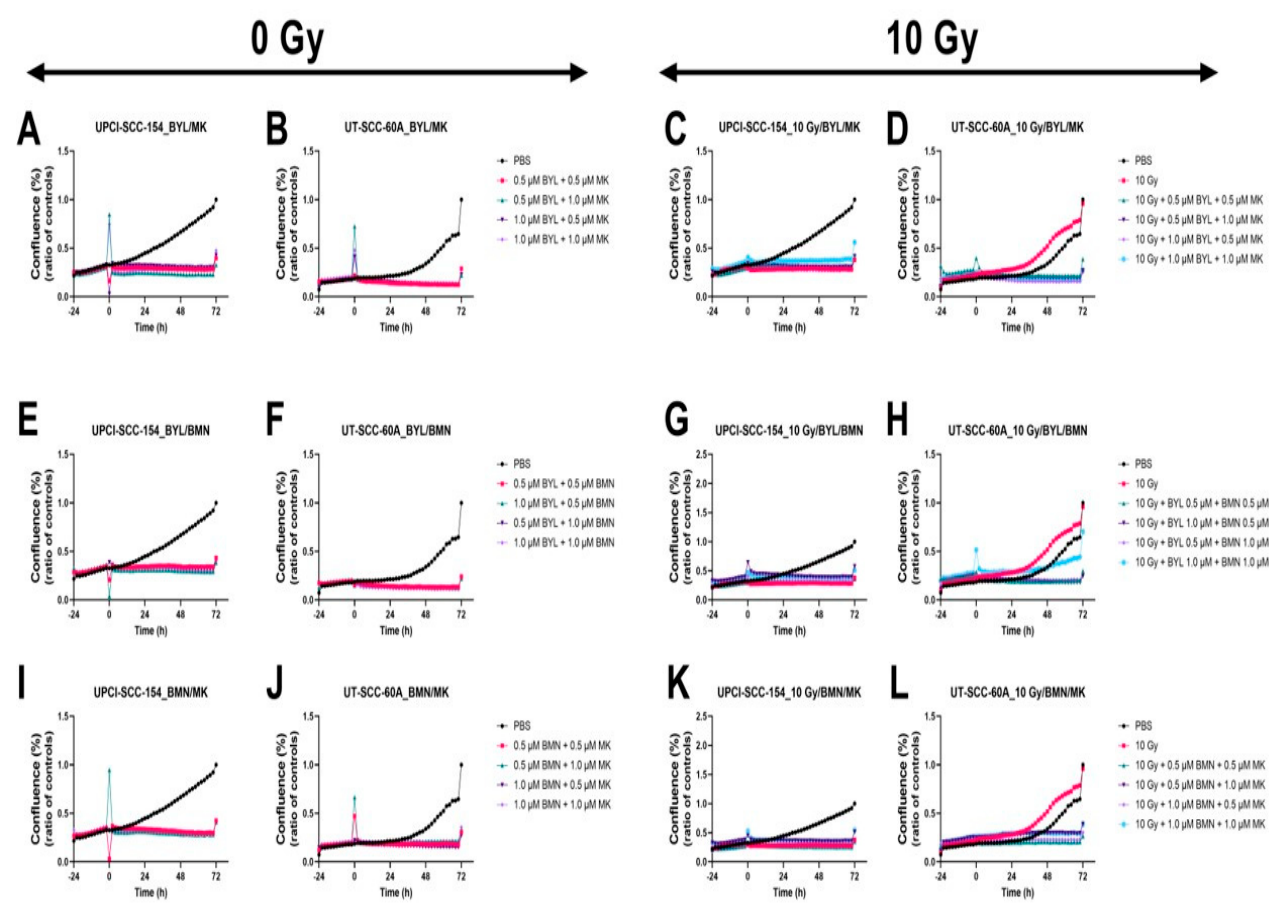
Figure 8. Proliferation responses of the HPV+ UPCI-SCC-154 and HPV − UT-SCC-60A cell lines upon treatment with MK-1775/BYL719 with/without (w/wo) 10 Gy ( A – D ), BYL719/BMN-673 w/wo 10 Gy ( E – H ), or MK-1775/BMN-673 w/wo 10 Gy ( I – L ). The graphs represent one experimental run per cell line. Confluence (%) denotes the proliferation response, BYL denotes BYL719, BMN denotes BMN-673, and MK denotes MK-1775.